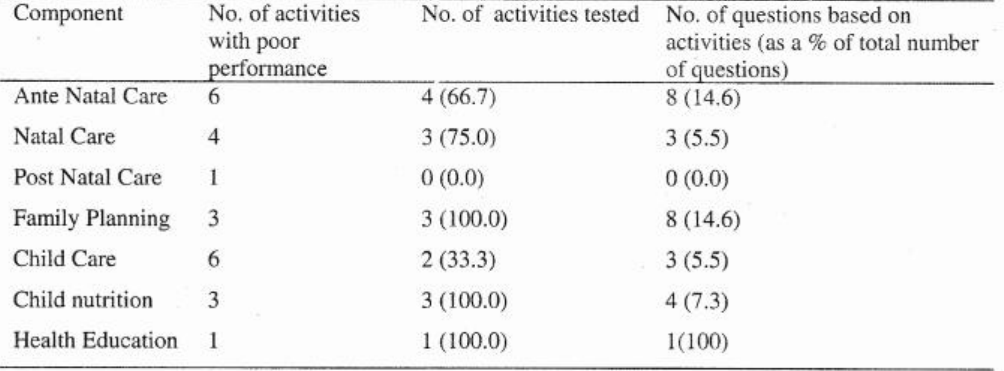
Table 2. Distribution of questions related to activities of deficient performance in 5